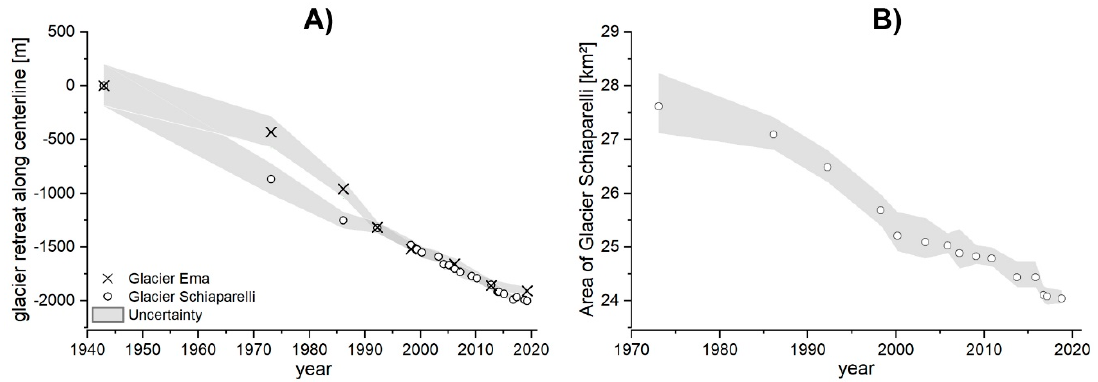
Figure 8. ( A ) Glacial recession along the centerline of Ema Glacier and Schiaparelli Glacier, derived from satellite imagery (Table A1). Uncertainty values were calculated according to Equation (1). For historical information of 1943, an uncertainty value of ± 100 m was assumed. ( B ) Area loss of the Schiaparelli Glacier. Uncertainty values were calculated applying a bu ff er of ± 0.5 pixel of the sensor used.